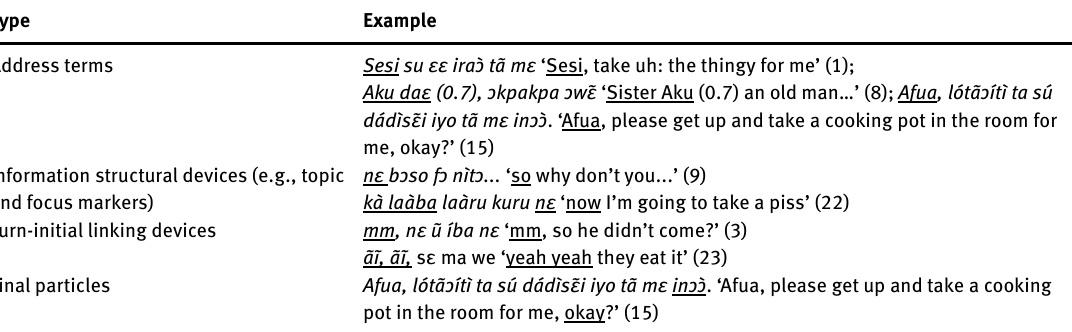
Table 7: Some types of items omitted in resayings (underlined, with reference to